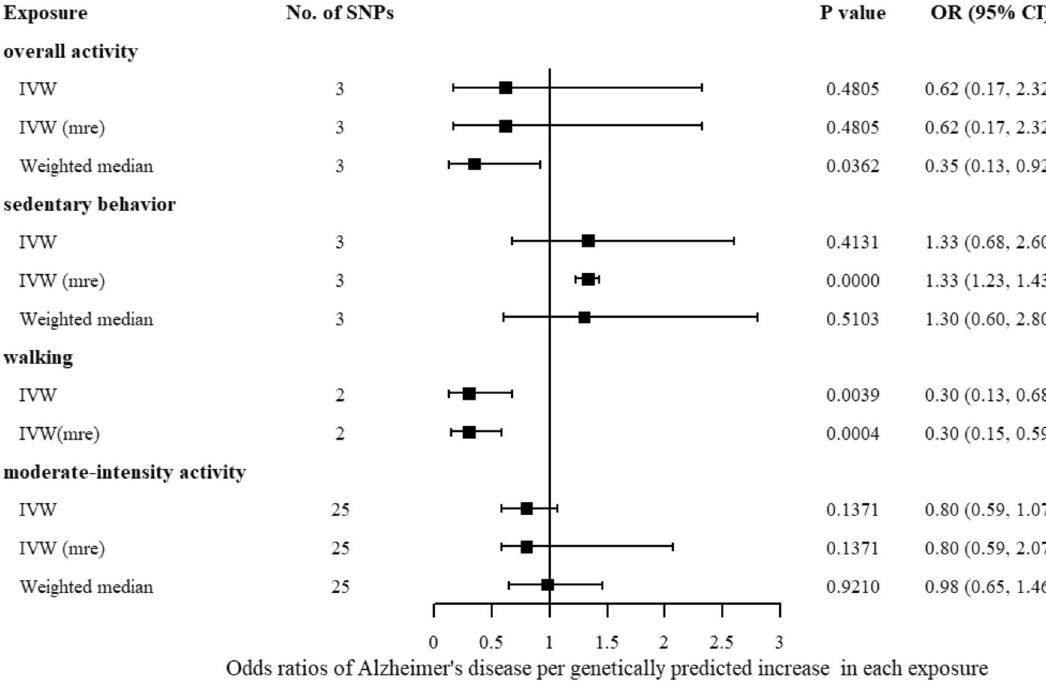
Figure 1. Forest plot for MR analysis of the causal effect of physical activity on Alzheimer’s disease. SNPs, single nucleotide polymorphisms; No. of SNPs, number of SNP; OR, odds Ratio; 95% CI, 95% confidence interval; IVW, inverse variance